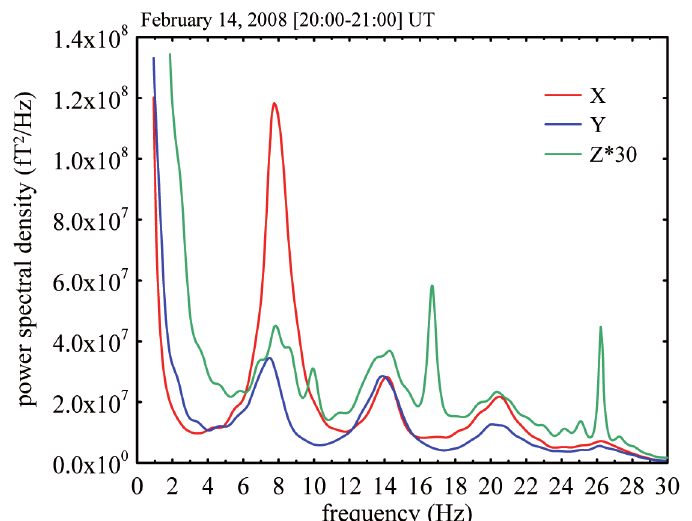
Fig. 7. An example of the SR spectral resonance structures. The first four harmonics are evident in all the three components. The Z component shows also two peaks at frequencies ≈ 16.7Hz and ≈ 26.2Hz due to artificial signals. For clarity the values of the Z component are multiplied by 30.